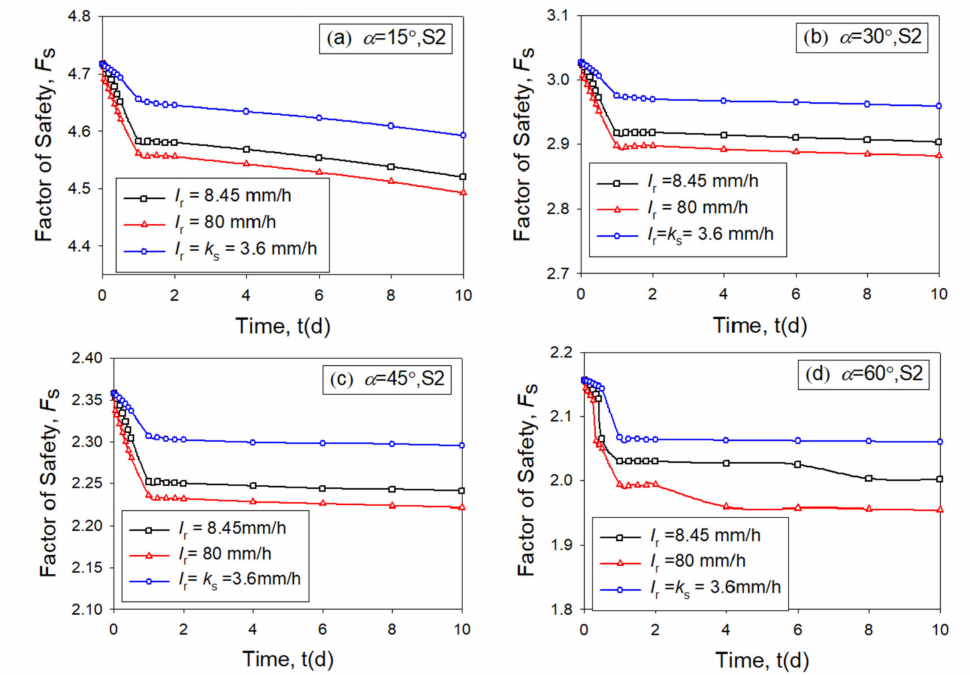
Figure 5. Variation diagram of F s of soil S2 for the slope with different slope angles, ( a ) α = 15 ◦ ; ( b ) α = 30 ◦ ; ( c ) α = 45 ◦ ; ( d ) α = 60 ◦ .